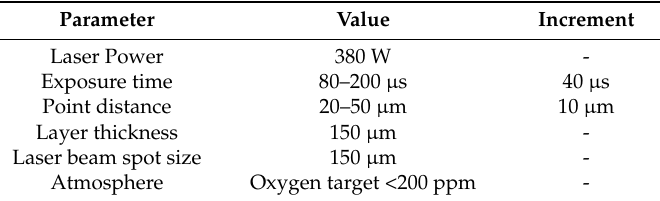
Table 2. Single-track experiments of process parameters.